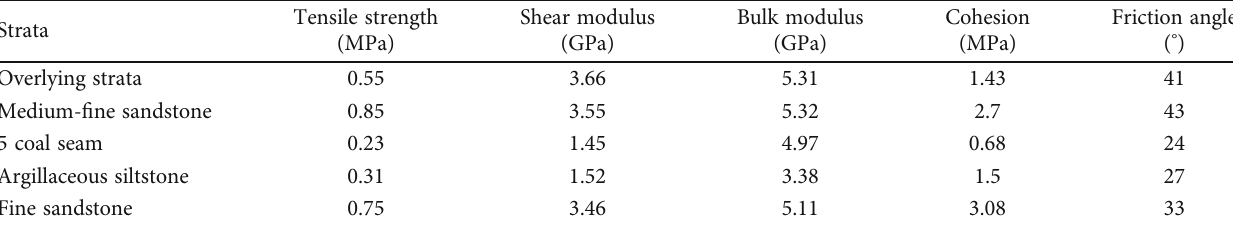
Table 1: Main rock parameters of main strata in the model.